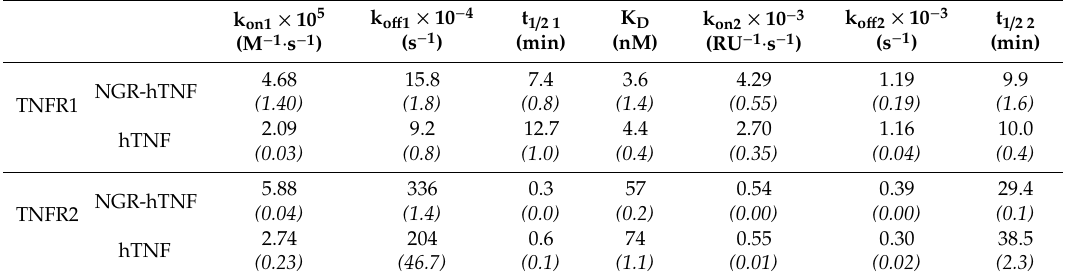
Table 2. Association constant and kinetic parameters for NGR-hTNF and hTNF interaction with TNFR1 and